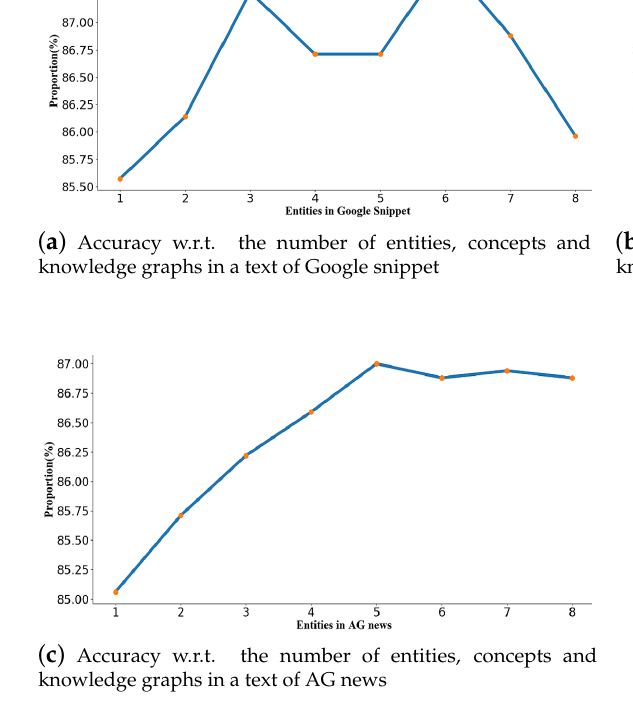
Figure 4. The distributions of